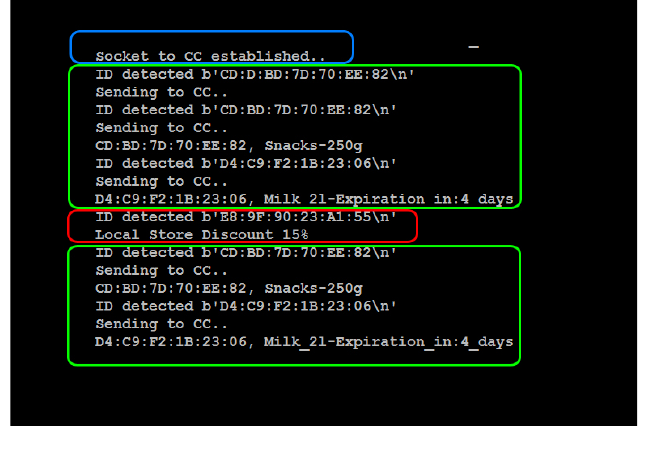
Figure 6. Simulation of data verification in the Fog / CC